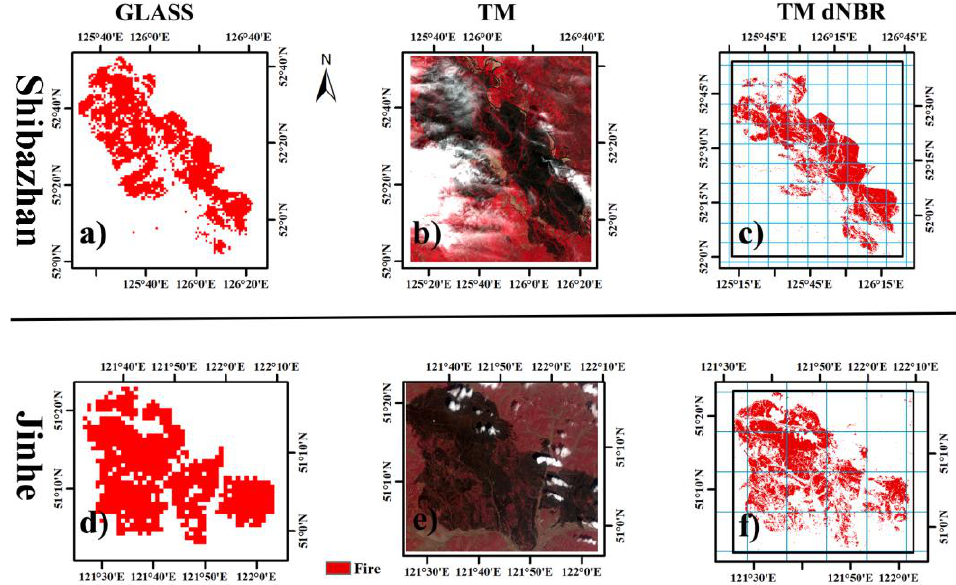
Figure 8. Regional images of the 2003 GLASS and Landsat fire disturbance in Shibazhan and Jinhe. The comparison results of two algorithms in Shibazhan are shown in the upper row: ( a ) TSM results; ( b ) Landsat image; ( c ) Landsat dNBR results. The comparison results of two algorithms in Jinhe are shown in the bottom row: ( d ) TSM results; ( e ) Landsat image; ( f ) Landsat dNBR results. The Landsat image is displayed in band 4 (red), 3 (green), 2 (blue) color composite. The cyan boxes in the differenced NBR (dNBR) represent 10 × 10 GLASS